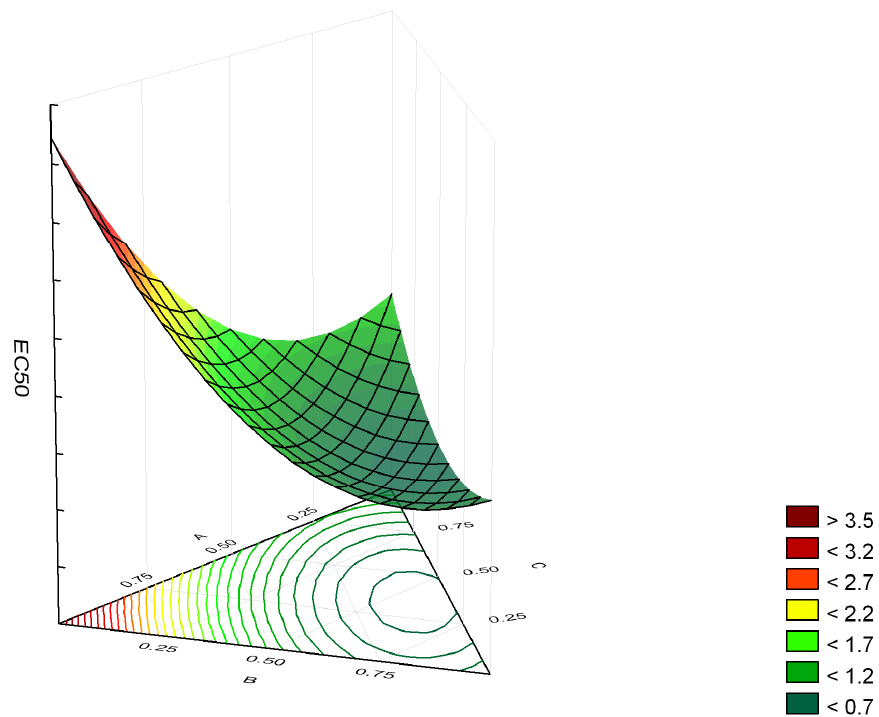
Figure 3. Fitted surface for best mixture OE in terms of antioxidant properties (cedarwood (A), citronella (B), thyme (C), compound D = 0.03)).